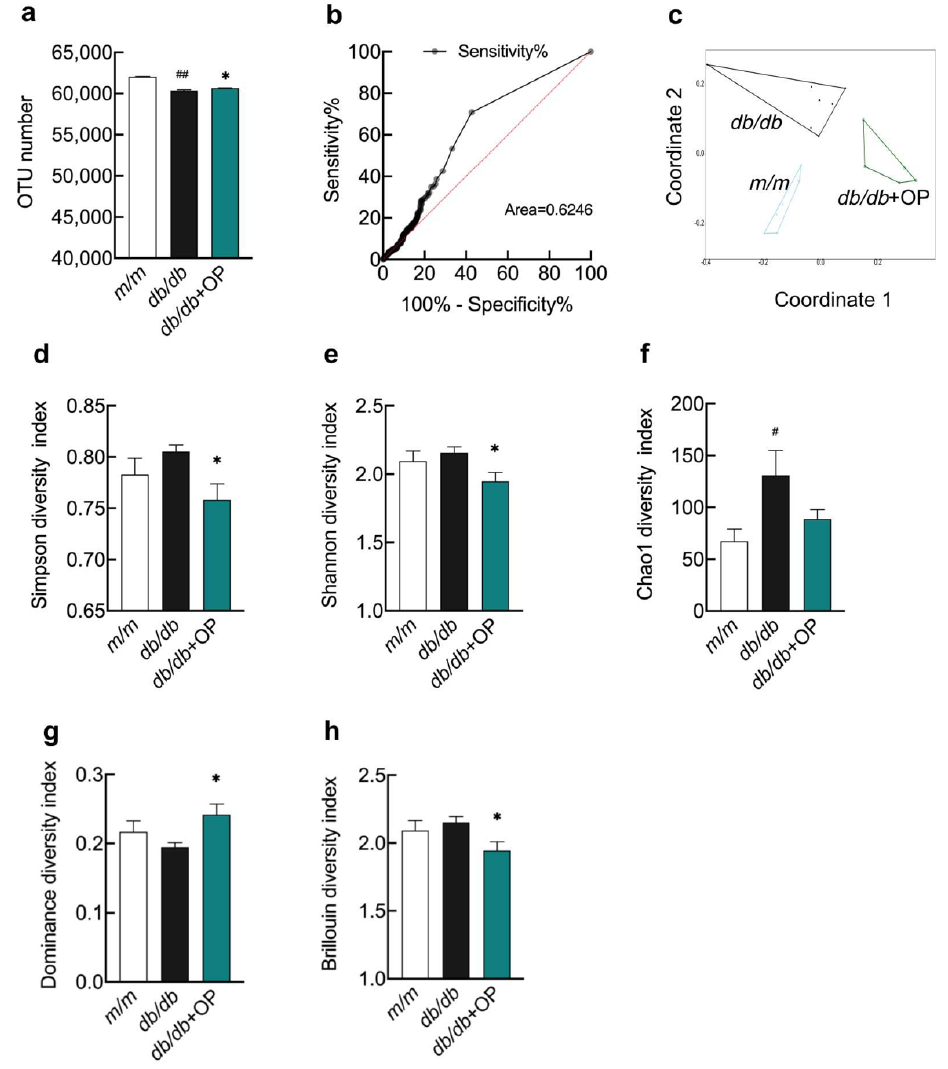
Figure 4. The effects of OP treatment on α - diversity and β -diversity of gut microbiota in db / db mice. ( a ) OTU numbers of m / m group mice, db / db group mice, and db / db + OP group mice; ( b ) The ROC curve; ( c ) NMDS plot based on the Bray – Curtis distances; ( d – h ) The α -diversity analysis, including Simpson, Shannon, Chao1, Dominance, and Brillouin diversity. # p < 0.05, db / db versus m / m ; ## p < 0.01, db / db versus m / m . * p < 0.05, db / db + OP versus db / db .